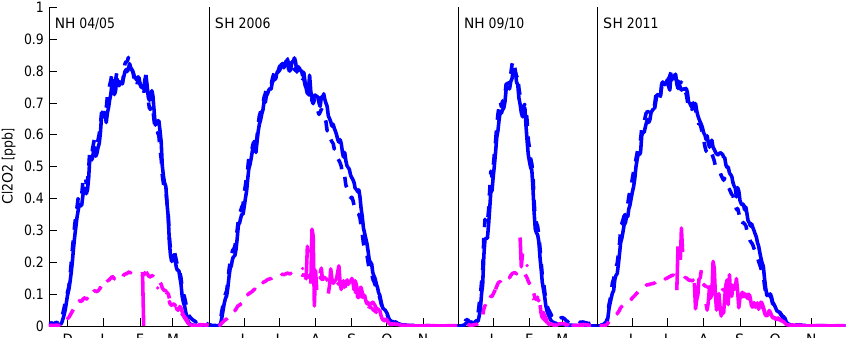
Figure 1. Vortex-averaged mixing ratio of Cl 2 O 2 for the Arctic winter 2004/2005, the Antarctic winter 2006, the Arctic winter 2009/2010 and the Antarctic winter 2011 at 54hPa (from left to right). Vortex average (solid blue) and parameterization for the mixing ratio by (cid:104)[ ClO x ](cid:105) ( 1 − FAS ) (dashed blue) and average over sunlit part of vortex (solid magenta) and parameterization for the mixing ratio by (cid:104)[ ClO x ](cid:105) (dashed magenta). Tick marks on the horizontal axis show start of